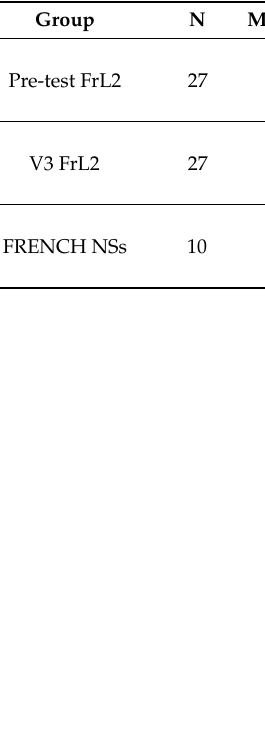
Table 4. Characteristics of FrL1 and FrL2 participants and their